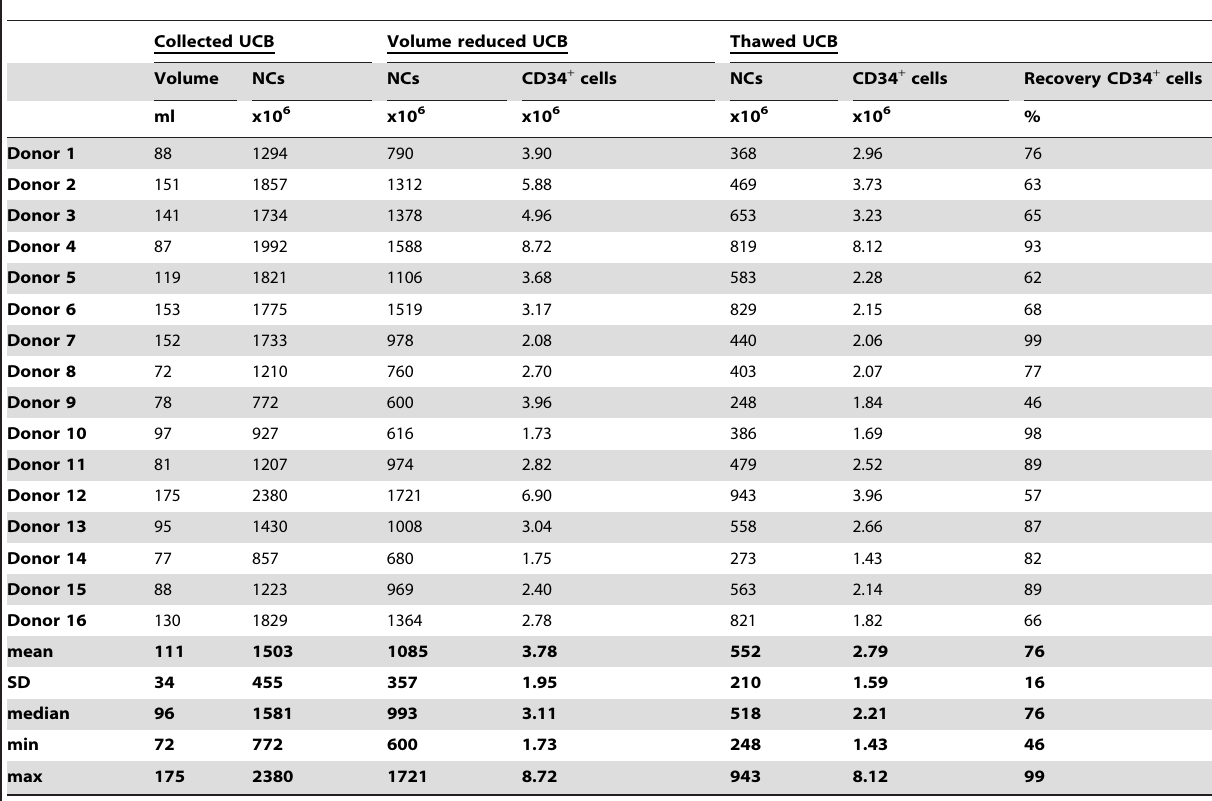
The table summarizes the processing of 16 UCB units used for CD34 + enrichment after collection, volume reduction and thawing process. Nucleated cells (NCs) were counted with the AcT10 counter (Beckman coulter). CD34 + cells were enumerated by single platform flow cytometry analysis. Results are depicted as mean, standard deviation, median, minimum (min) and maximum (max) volume, number of cells or percentages, respectively. doi:10.1371/journal.pone.0020740.t001 PLoS ONE |